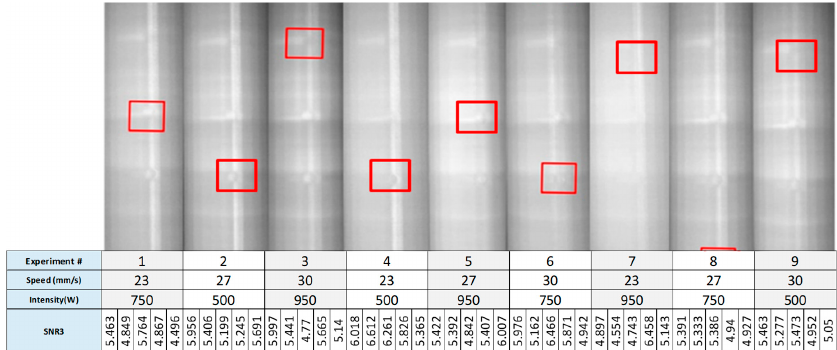
Figure 4. Quadrant 1-Line scan results of the nine experiments, red squares indicate locations of the defects with the highest SNR.